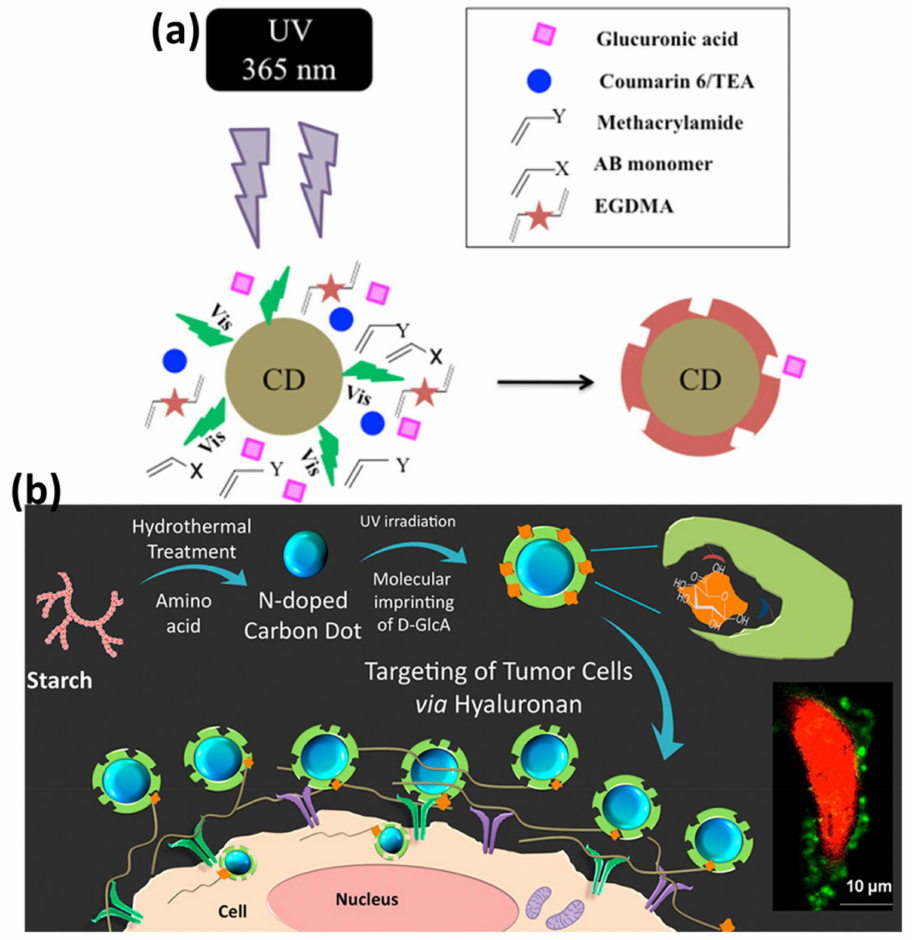
Figure 5. ( a ) CDs triggers the photopolymerization of MIP shell. ( b ) Schematic representation of core–shell CD-MIPs for biotargeting of tumor cells via hyaluronan. Reproduced with permission from ref. [93] © 2023 American Chemical